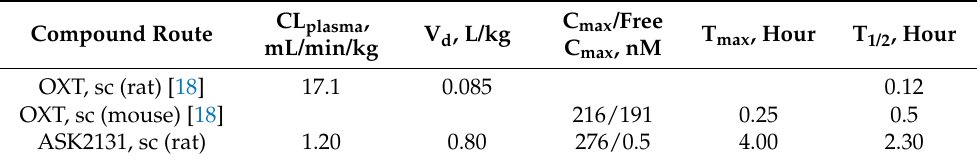
Table 2. Pharmacokinetic parameters for oxytocin (OXT) [2] and ASK2131 following subcutaneous (sc) administration to rats and mice.